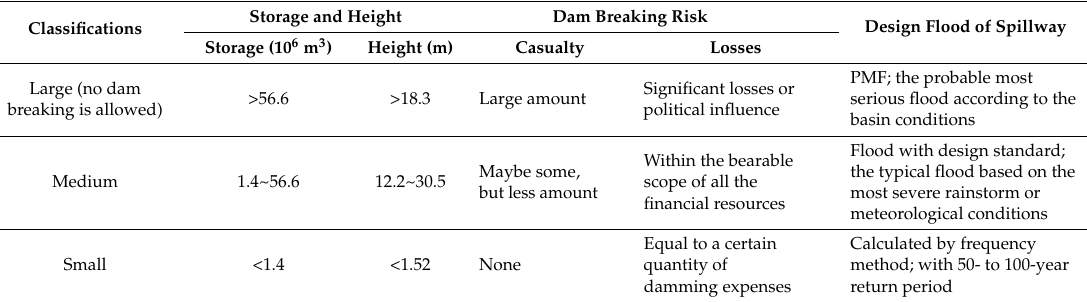
Table 11. Design flood control standard for spillway in